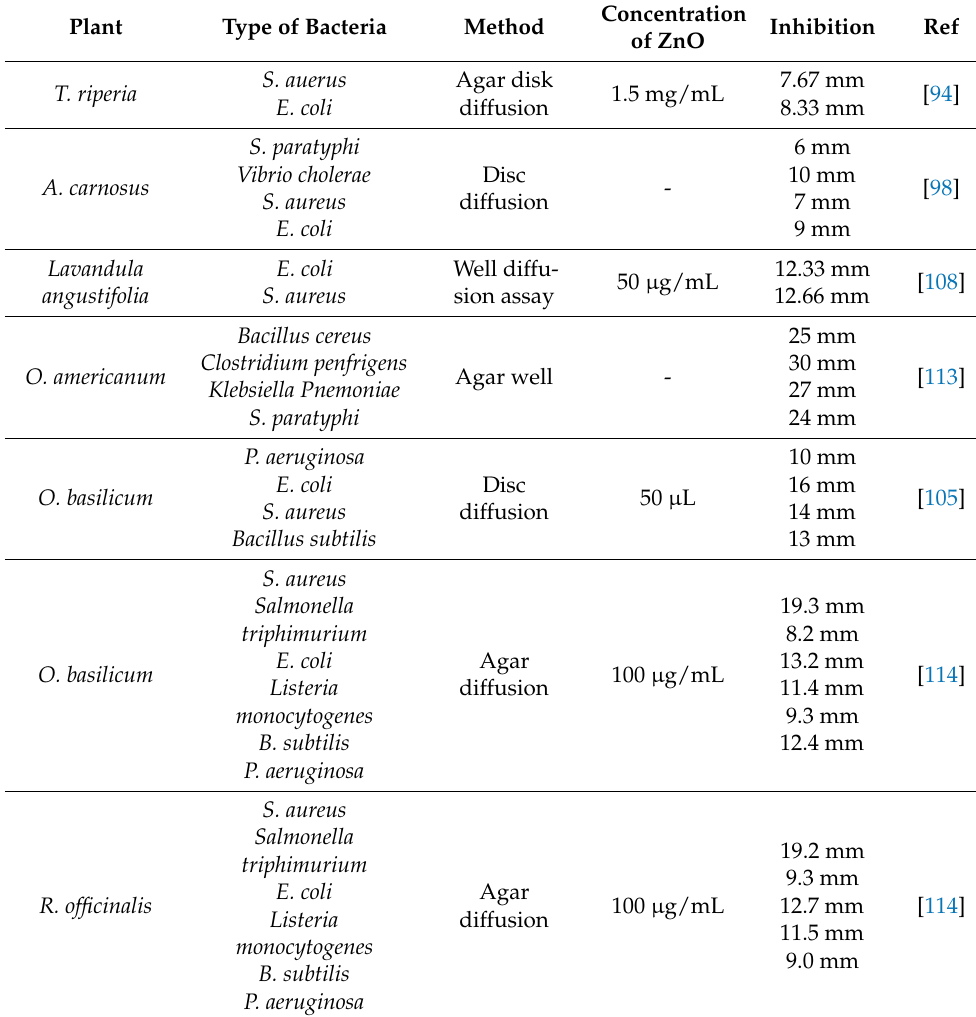
Table 2. The ZOI, method, and type of inhibited bacteria for some Lamiaceae-mediated ZnO NPs. Plant Type of